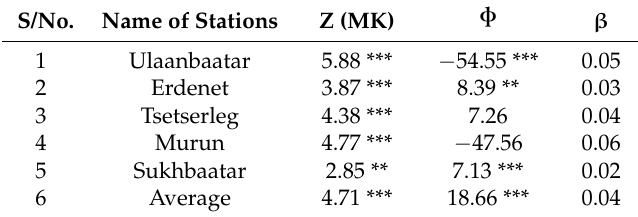
Table 3. The result of Z-statistic of MK, ITAM ( ф ), and Sen’s slope estimator test ( β ). S/No.